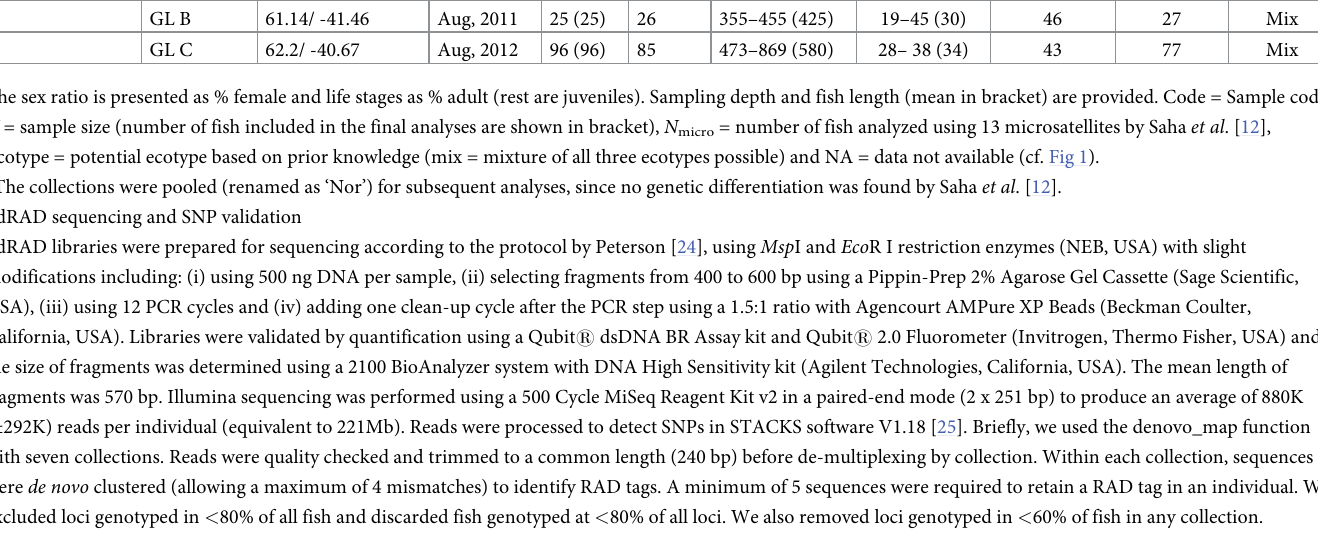
ddRAD sequencing and SNP